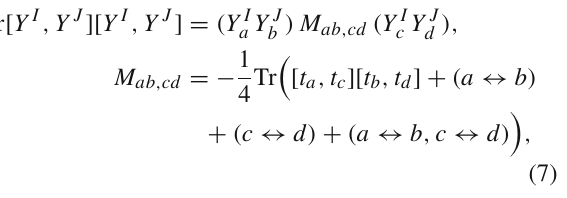
Fig. 1 Phase structure in 2D SYM (2). As going to the right side, it becomes a more higher-temperature region. On the other hand, as going up, it becomes a more strongly coupled region. The “1st” in the upper- left region can be known from the GL instability in the gravity side. The bottom-right region separated by the fine dotted line is the region effectively described by our 1D model (1); “uniform”, “non-uniform” and “gapped” represent the